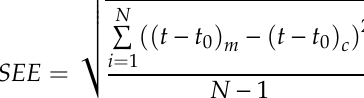
Table 7. For the considered emptying and filling processes, h range, runoff discharge, R , and runoff coefficient,  , and corresponding main statistics.